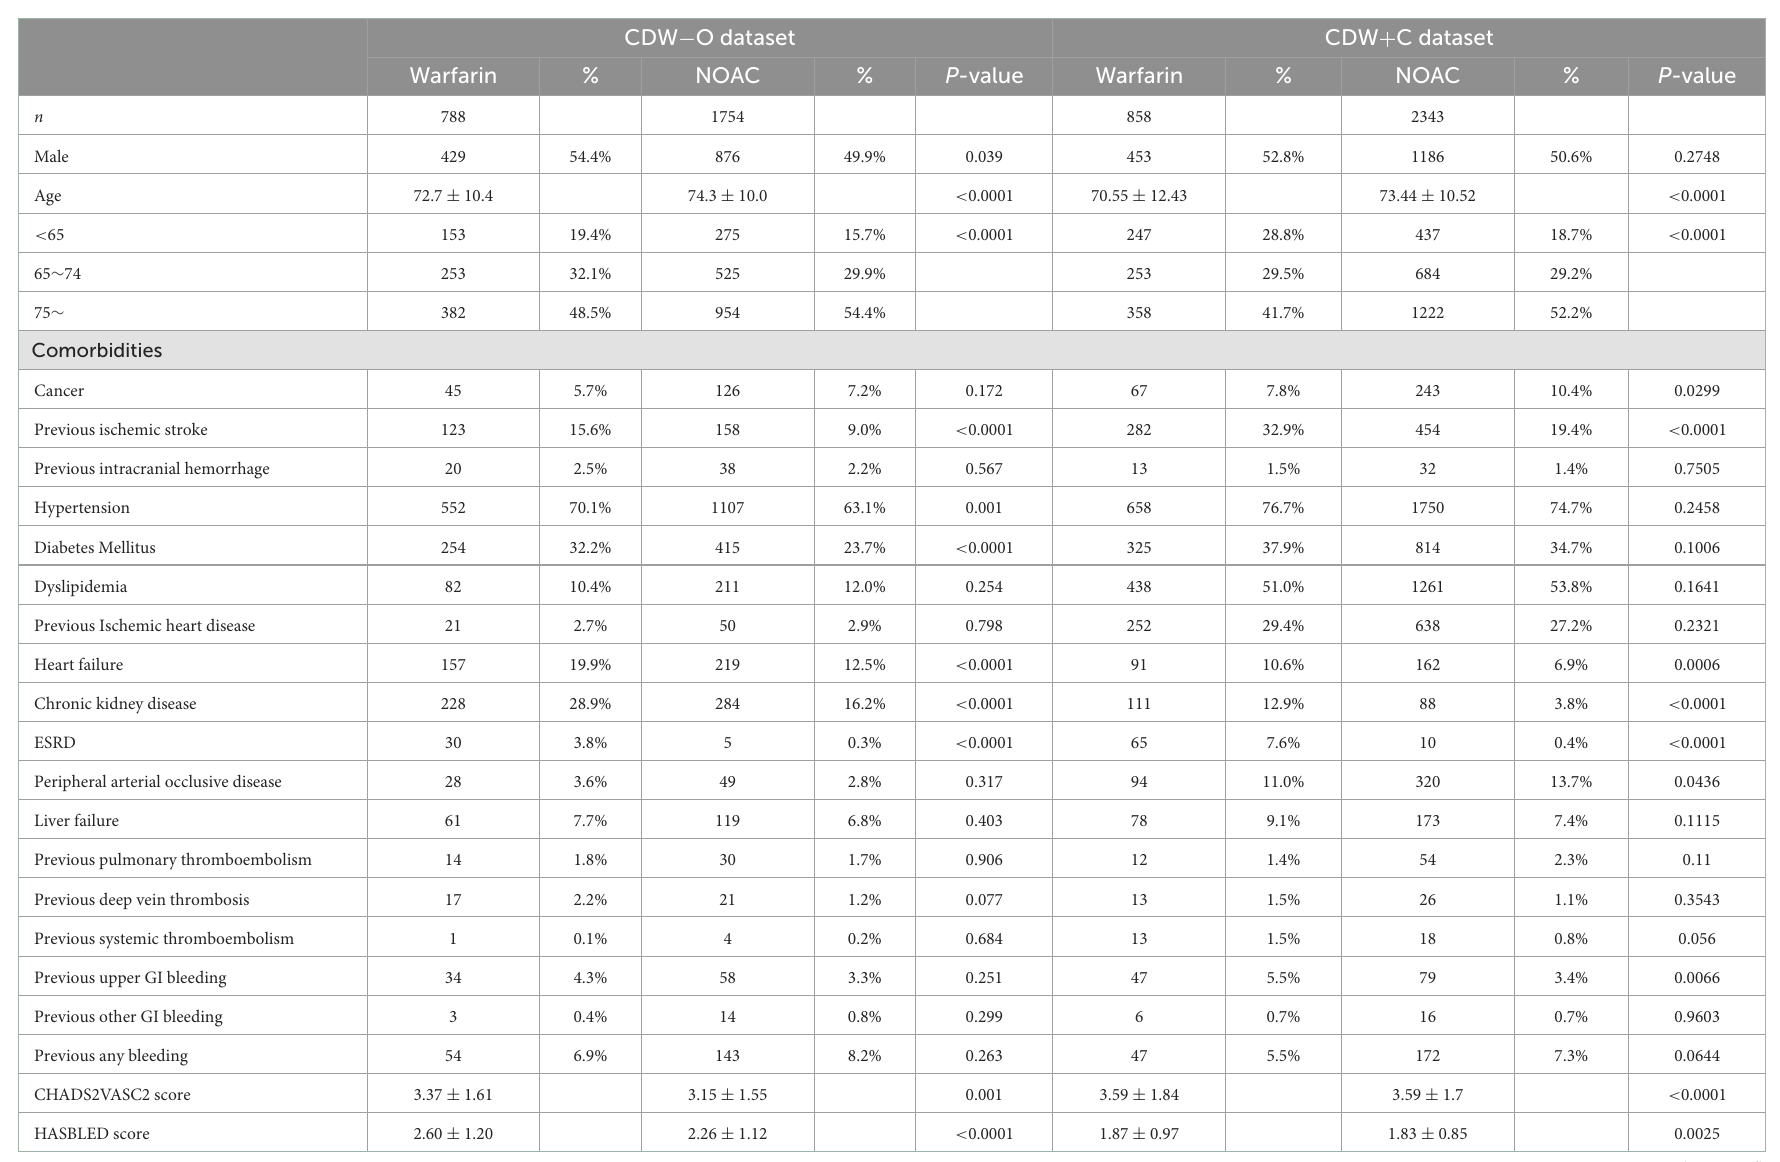
TABLE 1 Clinical characteristics and outcomes of patient groups divided according to